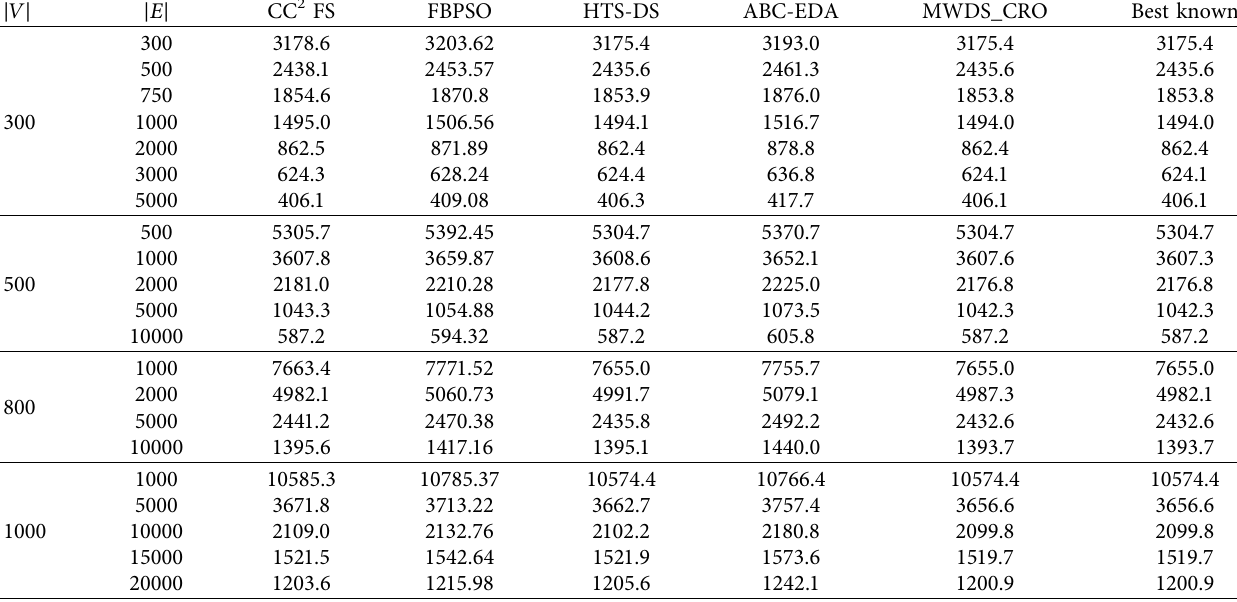
Table 4: Type TI class LPI-comparison of MWDS_CRO for various parameters with recent state-of-the-art algorithms. | V